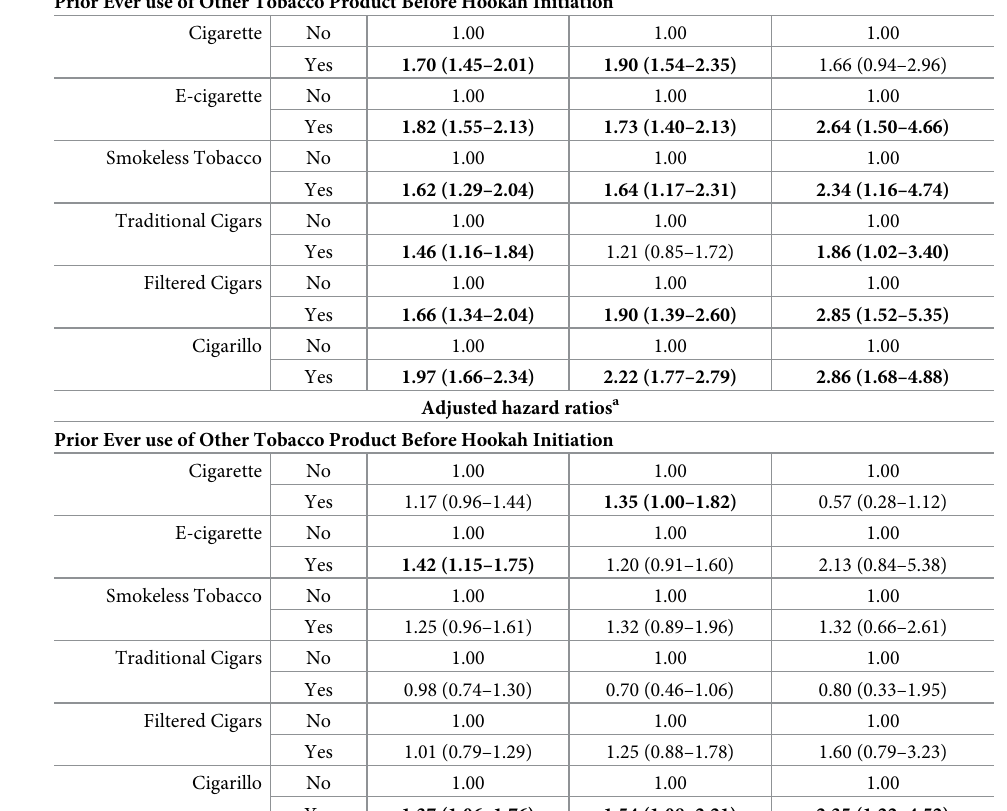
Table 6. Association of prior ever other tobacco product use with the age of initiation of hookah use behaviors for the PATH¥ young adults (aged 18–24). Ever Use Past 30-day Use